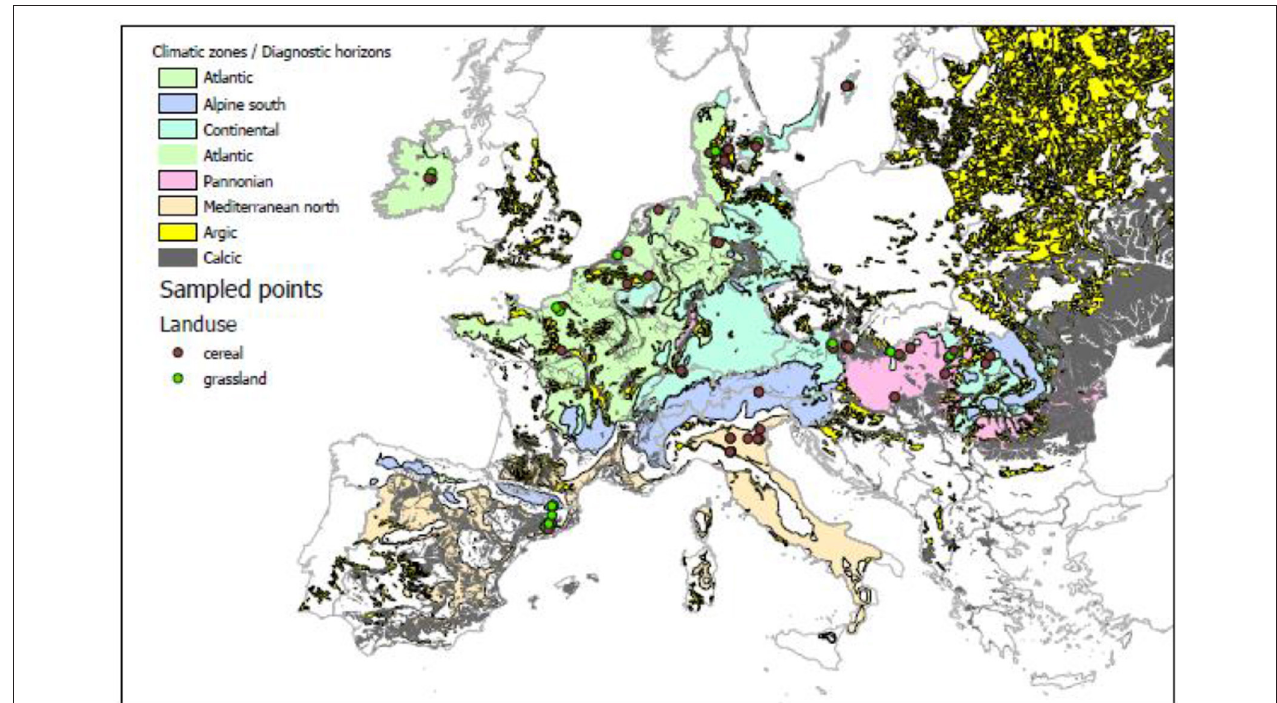
FIGURE 1 | Map showing the 94 soil monitoring points across Europe, including land use and climatic zone.